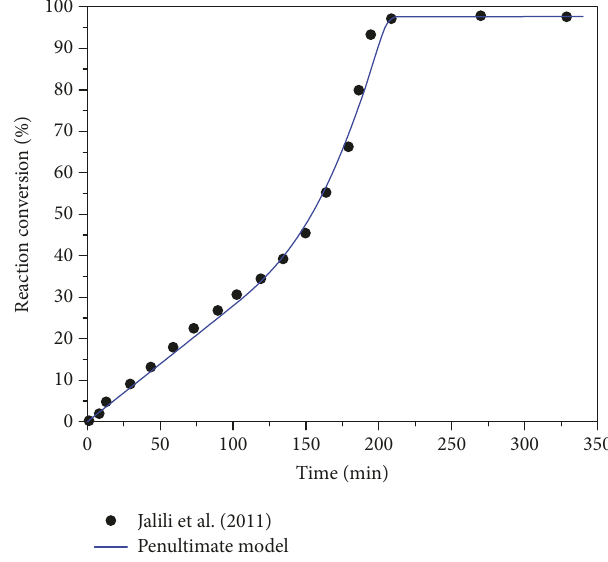
Figure 3: E ff ect of (a) temperature and (b) initiator concentration on the conversion pro fi les. M = 0 472 , r = 0 454 , r = 0 472 , r = 0 454 , s = 0 412 , and s r 11 12 21 22 1